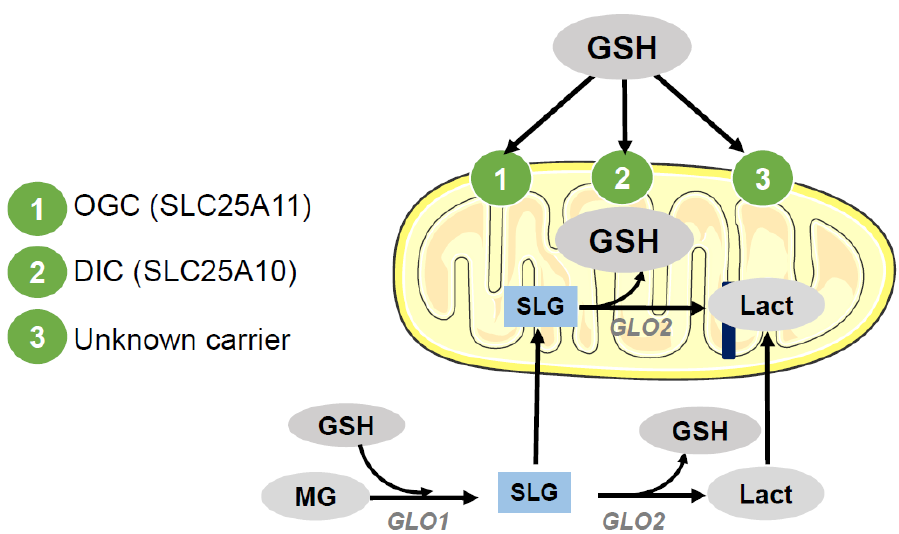
Figure 4. GSH transport to mitochondria. Once GSH is synthesized in the cytosol it can be transported to the mitochondria by specific IMM carriers: 2-oxoglutarate carrier (OGC; SLC25A11) and dicarboxylate carrier (DIC; SLC25A10), although the presence of unknown carriers cannot be discarded at present. In addition, S- d -lactoylglutathione (SLG), a stable intermediate product of the glyoxalase (GLO1) system which catalyzes the conversion of methylglyoxal (MG) into d -lactic acid (Lact), can enter the mitochondria and by the action of mitochondrial glyoxalase II (GLO2), be hydrolyzed to lactate and mGSH.